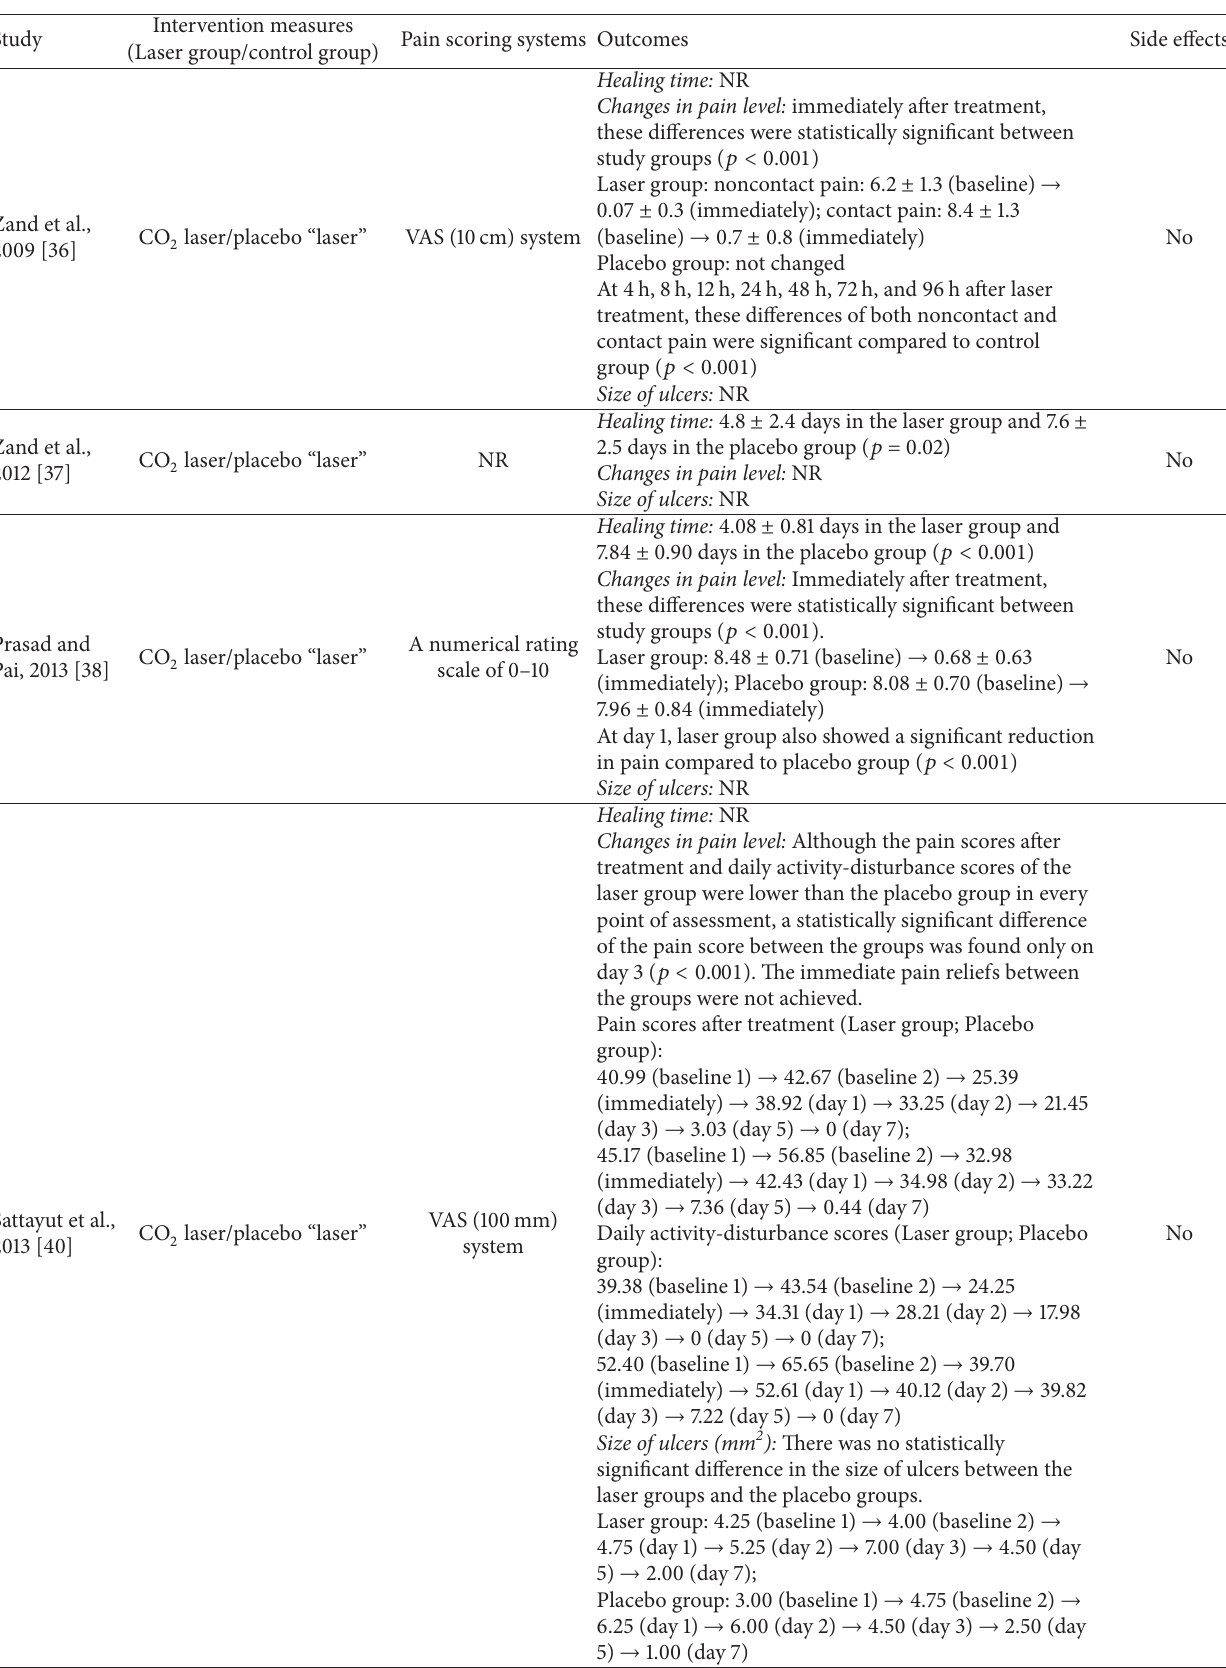
Table 4: Details of the effects of different intervention measures for RAS patients in the included studies.